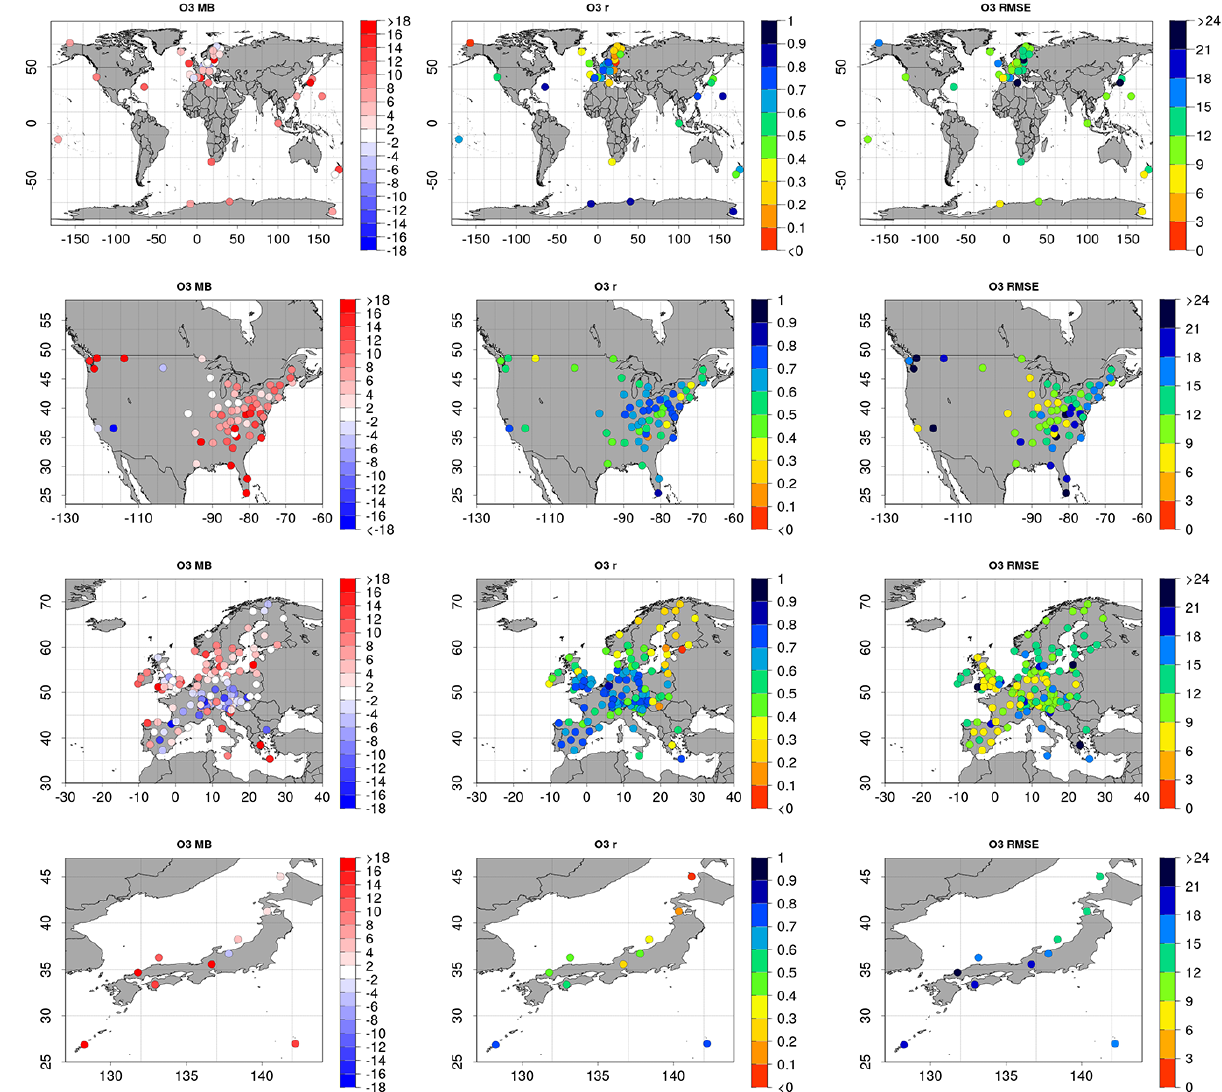
Figure 12. Spatial distribution of the O 3 mean bias (MB, ppb) (left panel), correlation ( r ) (middle panel) and RMSE (ppb) (right panel) at rural WDCGG, CASTNET, EMEP and EANET stations (from top to